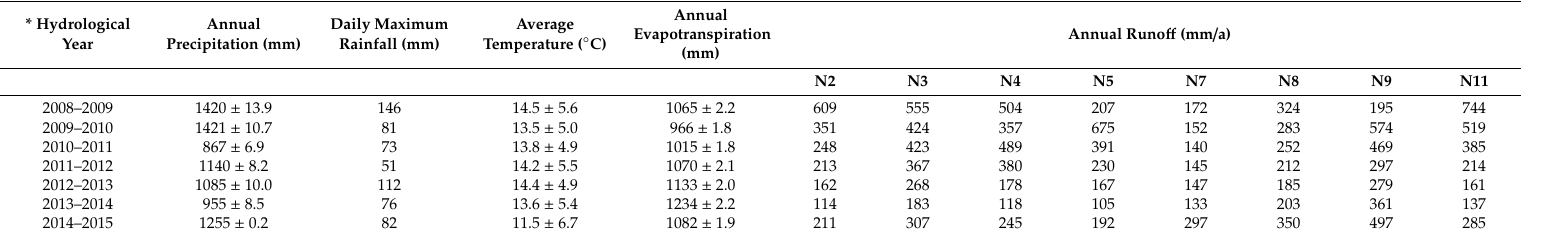
Table 2. Time series of rainfall, runo ff and temperature, correspond to the period 1 April 2008 and 31 March